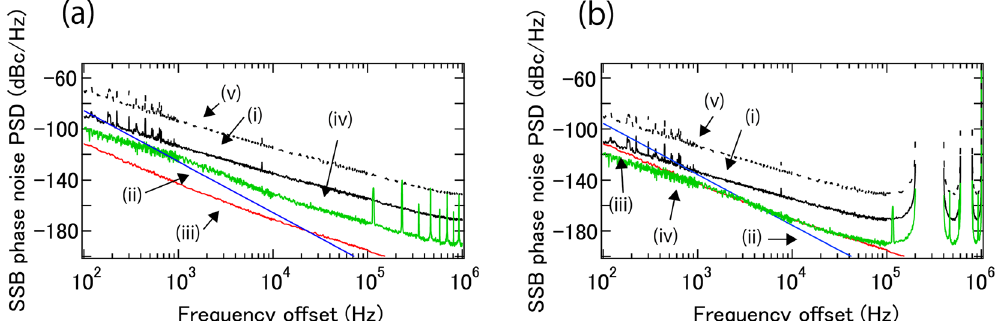
Figure 4. Sensitivity of the phase noise measurement for a 100 m fiber ( a ) and 1 km fiber delay ( b ) for + / − 10 th harmonics. (i, black), (ii, blue), (iii, red), and (iv, green) curves are sensitivity limits from background noise, fiber noise, cw laser noise, and intensity noise before PDs for the use of + / − 10th order sidemodes, respectively. (v, dotted black) curves are sensitivity limits from background noise for the use of + / − 1st order sidemodes.